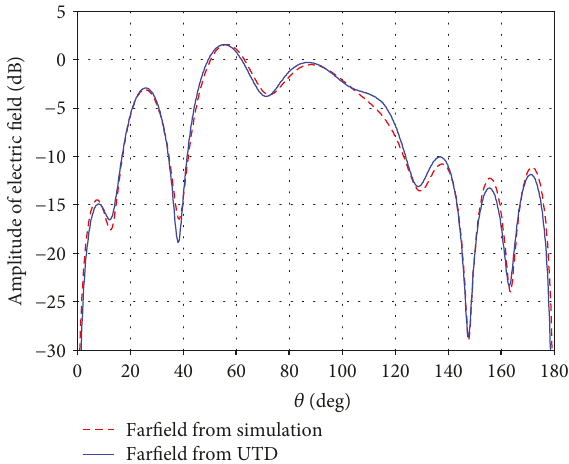
Figure 4: Double di ff raction for PEC square patch excited by a half-wavelength dipole antenna.